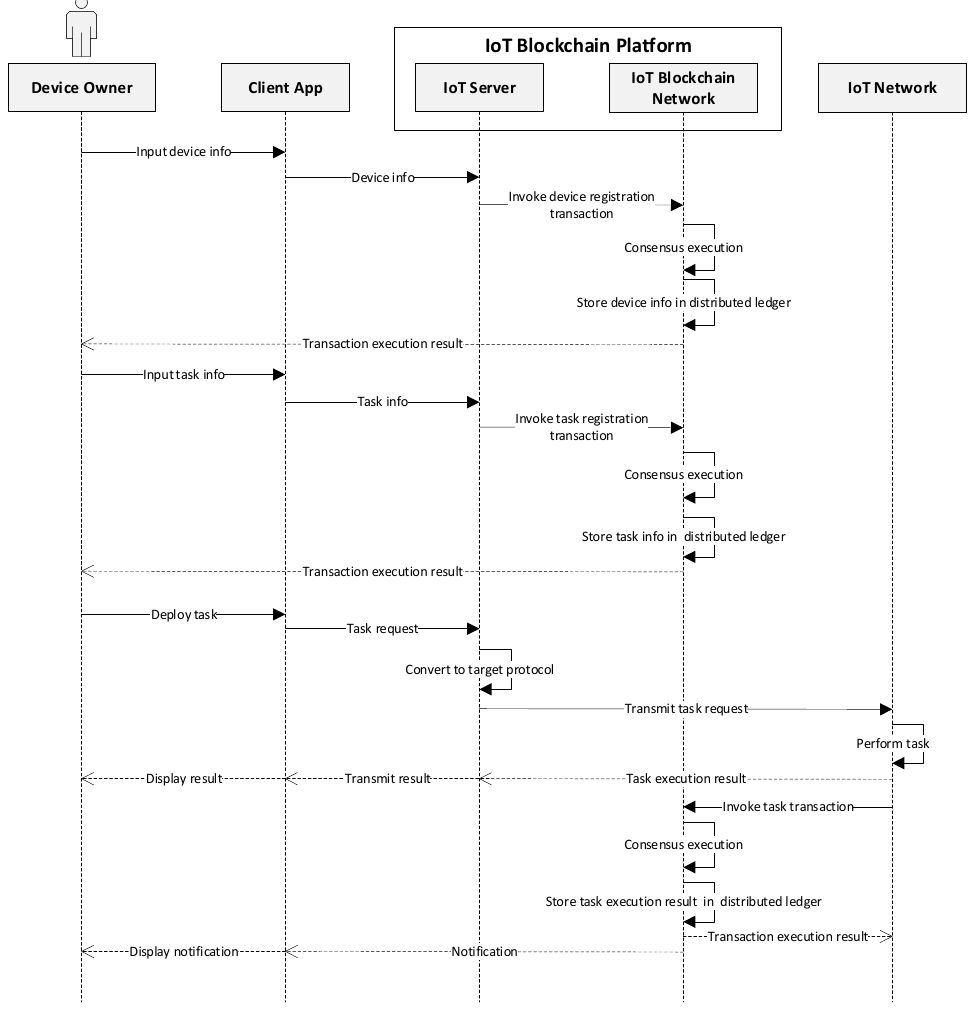
Figure 7. Sequence diagram of various operations within the proposed system.